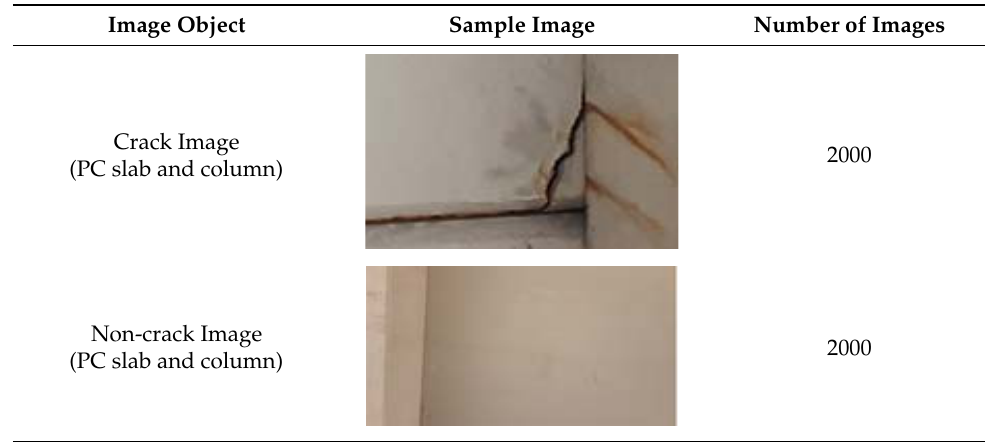
Table 4. Sample images of crack and non-crack taken using a mobile device camera.